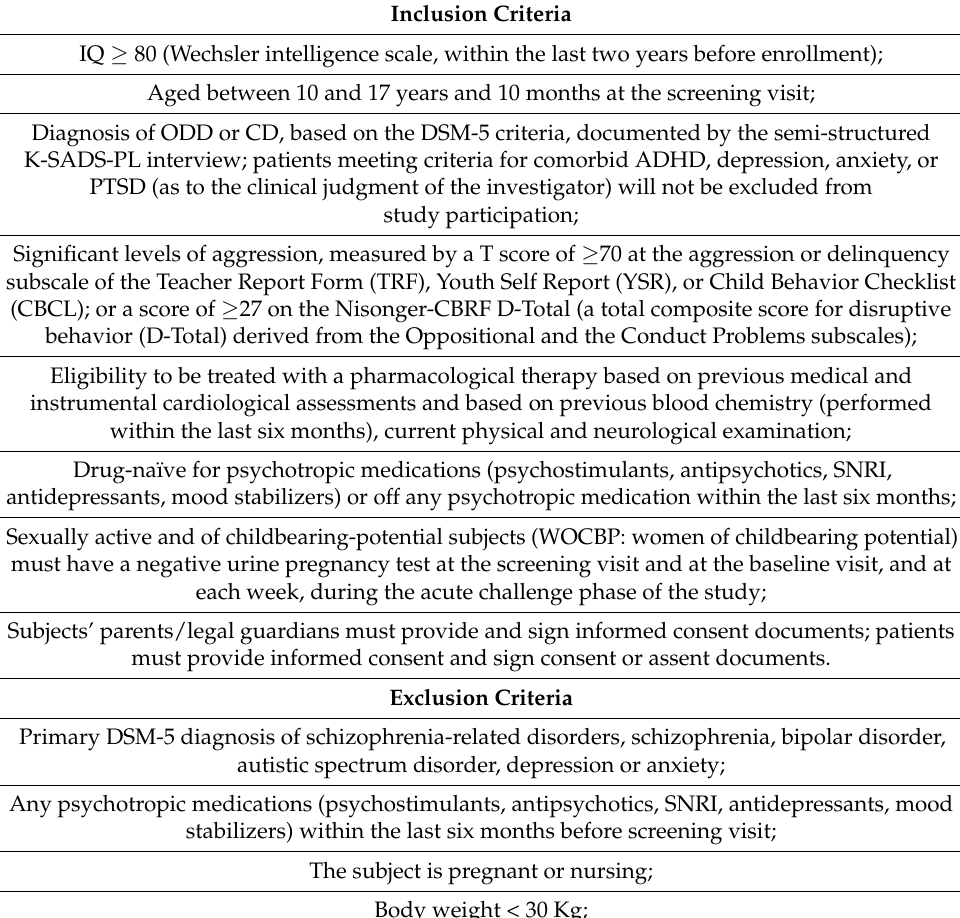
Table 2. Inclusion and exclusion criteria for ODD/CD